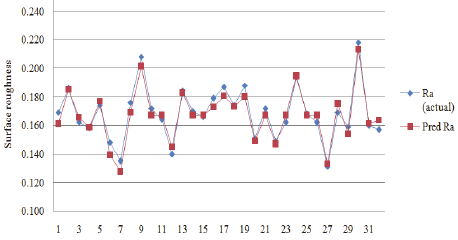
Fig. 4. Experimental and predicted values of surface roughness of EN31 soft